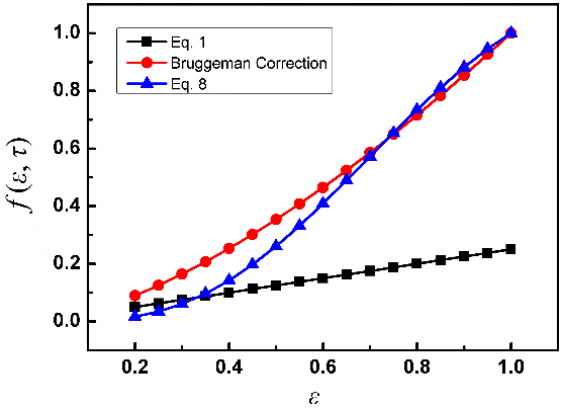
Figure 4. The impacts of porosity on f( ε , τ ) (